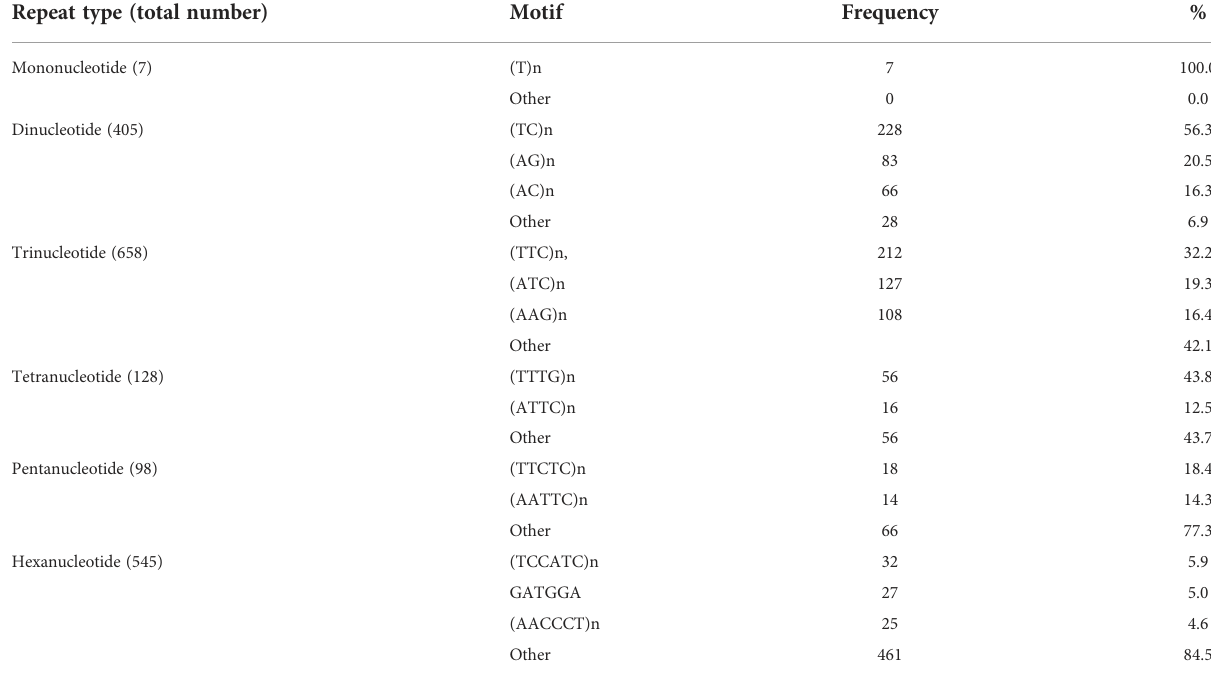
TABLE 1 Number and frequency of different types of SSR motifs in saf fl ower cDNA sequences (SSR length ≥ 18 bp). Repeat type (total